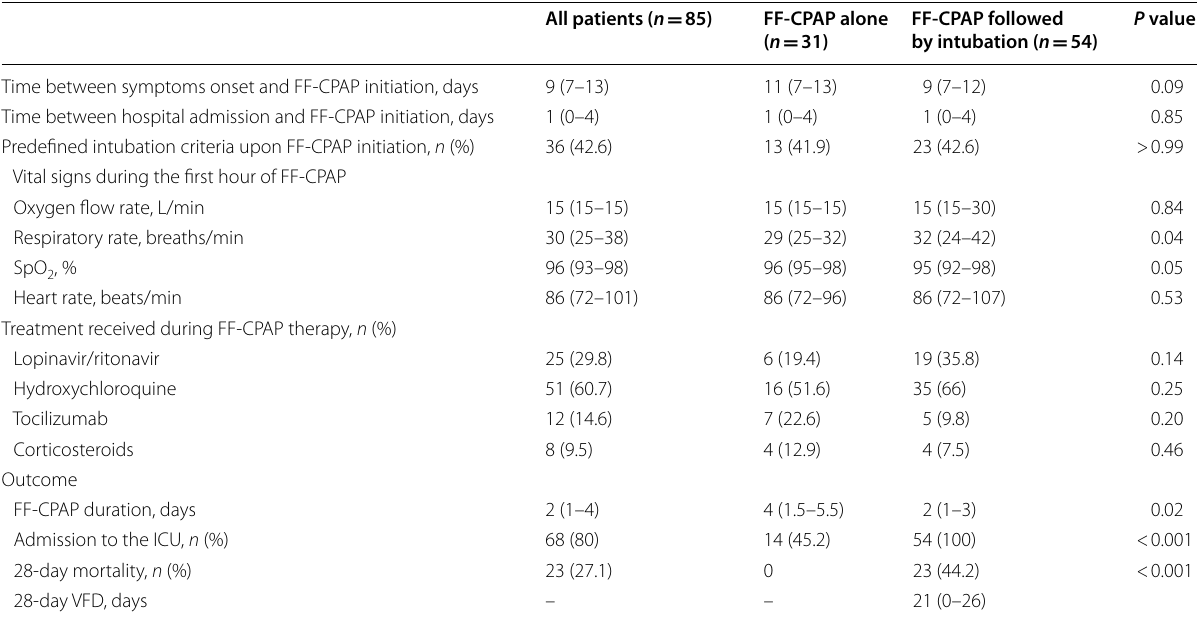
FF-CPAP filter frugal continuous positive airway pressure (see text for definition), VFD ventilator-free days